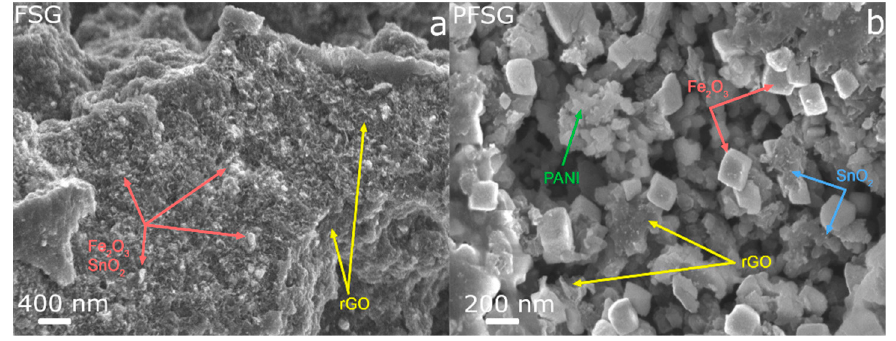
Figure 2. FESEM images of the binary ( a ) and ternary ( b ) composites.